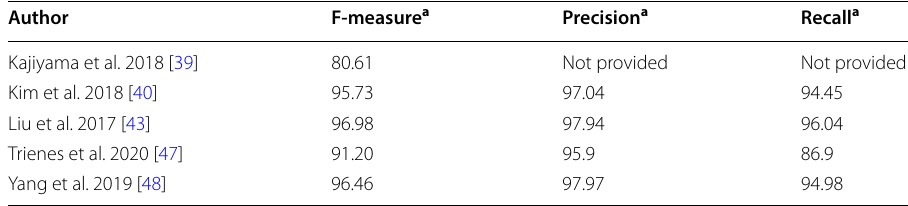
Table 6 (RNN CRF) papers on de‑identification of medical free text +